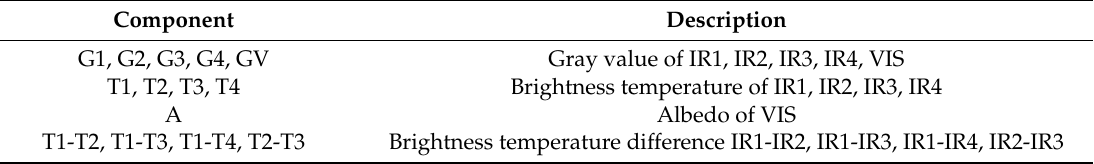
Table 2. The main identification characteristics of different components